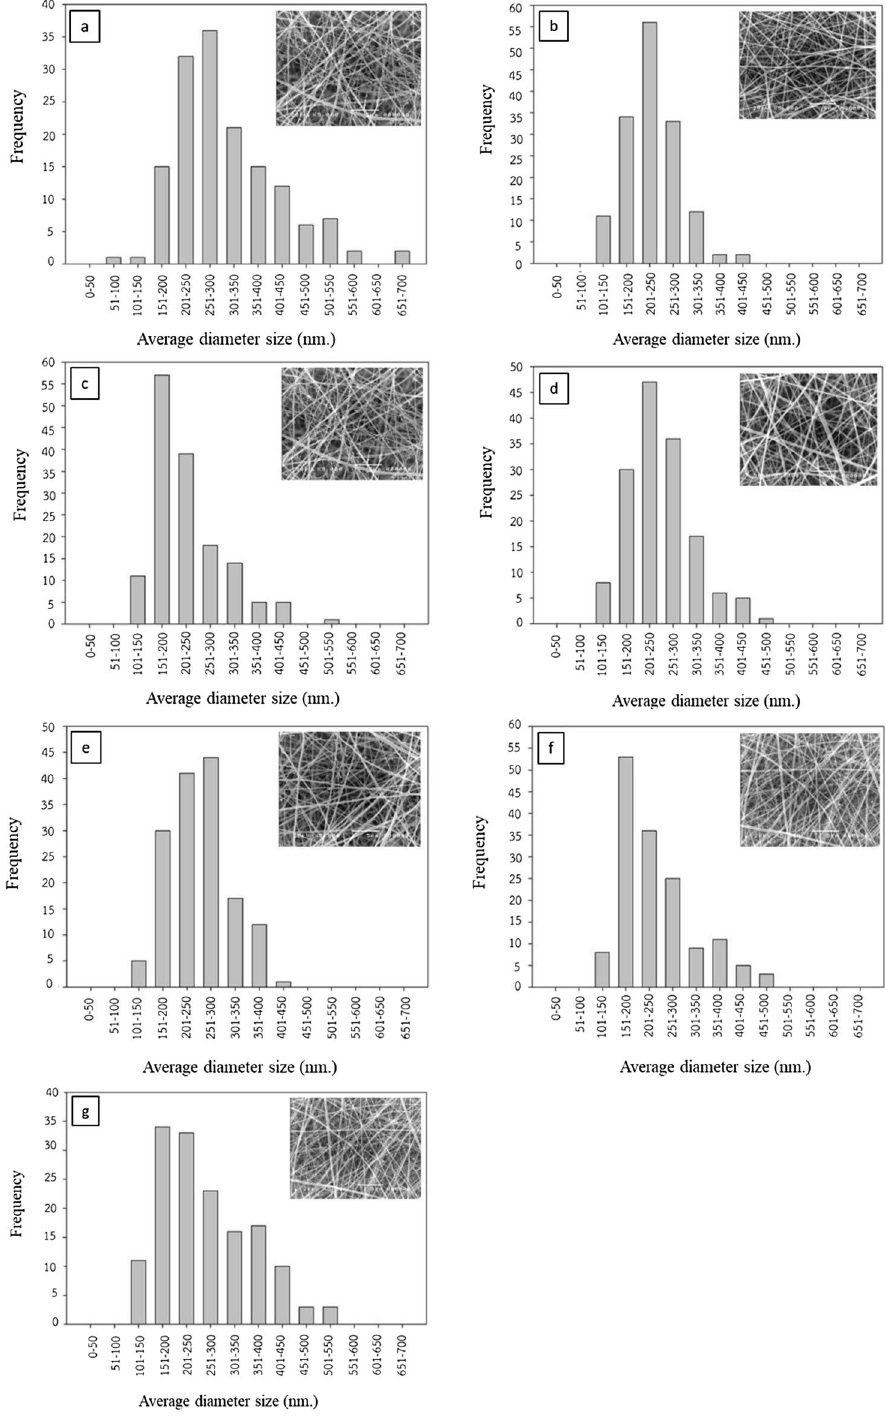
Figure 2. The distribution of the average diameter size of the fabricated nanofibers with SS/SF concentration ratio (%w/v) of ( a ) 0.0:0.0 ( b ) 2.5:2.5 ( c ) 3.0:2.0 ( d ) 3.5:1.5 ( e ) 4.0:1.0 ( f ) 4.5:0.5 ( g )